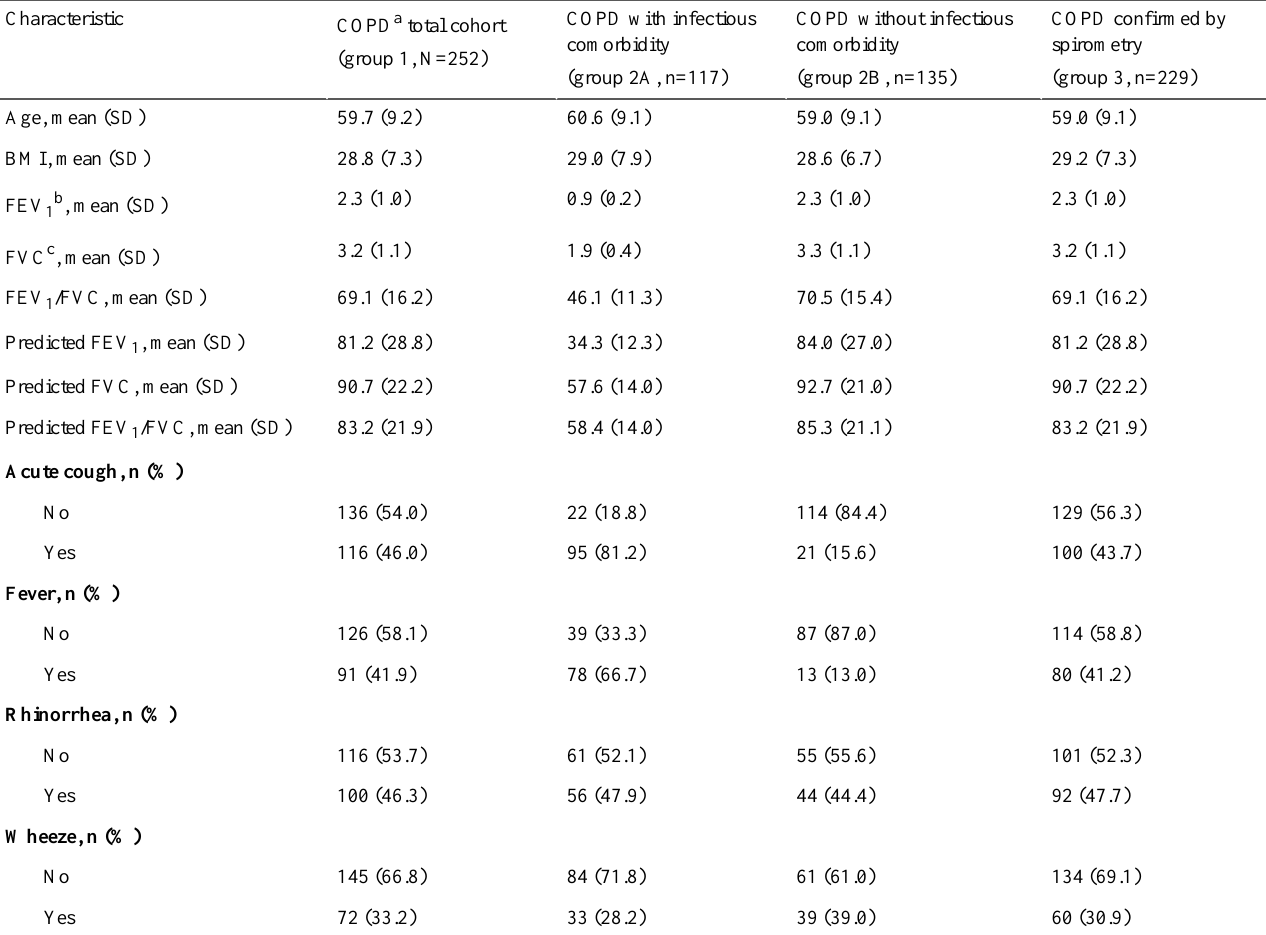
Table 3. Participant characteristics. Data include all participants in analyzed groups (COPD positive and